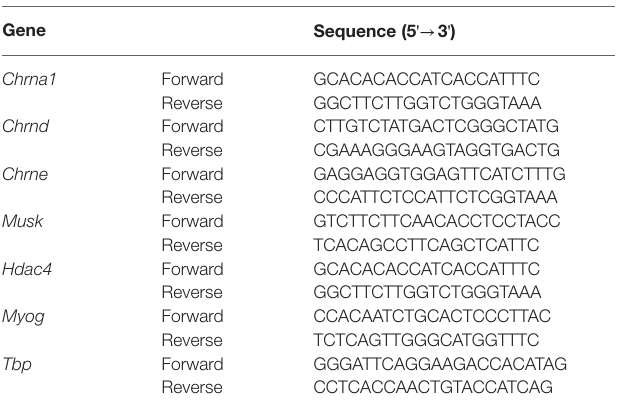
TABLE 1 | qPCR primer